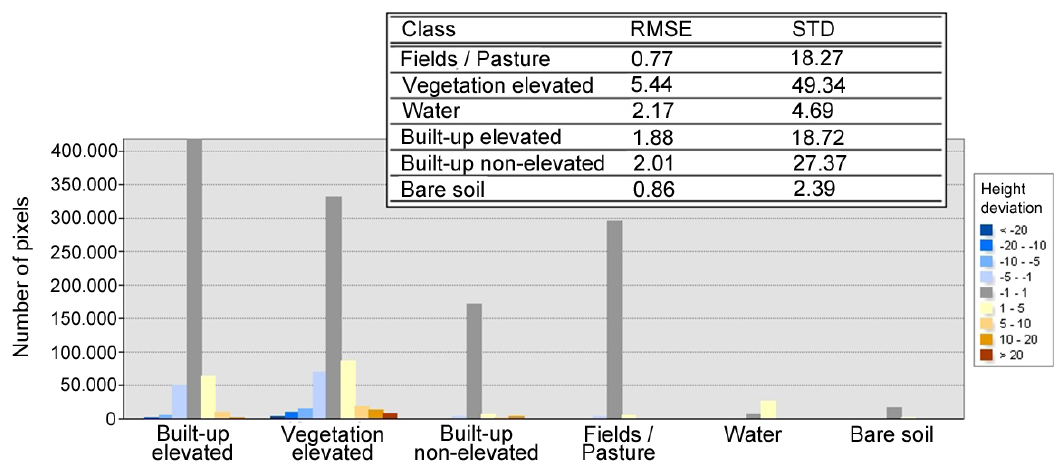
Figure 7. Height deviation of the computed stereo DEM in relation to the reference LiDAR-DEM, calculated for each class separately. RMSE: root mean square error; STD: standard